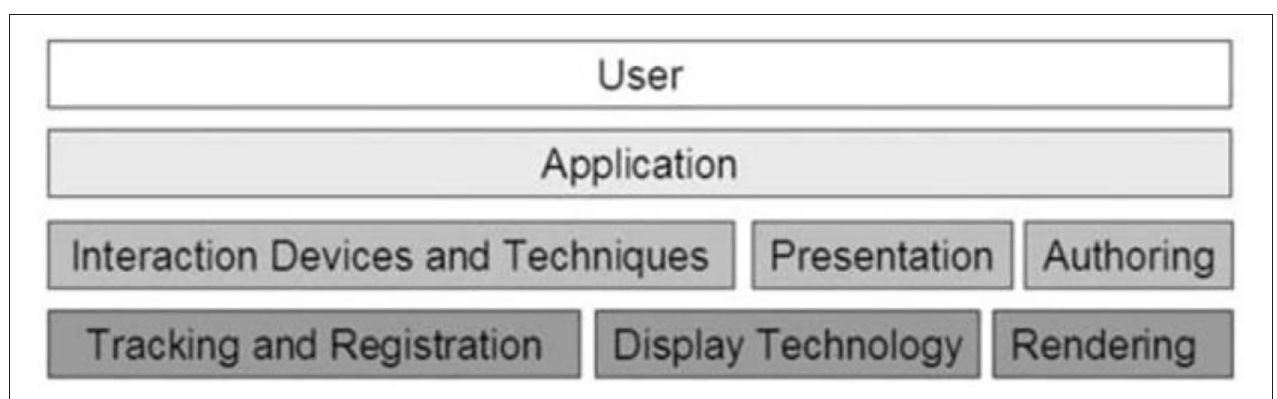
FIGURE 2 | The basics of augmented